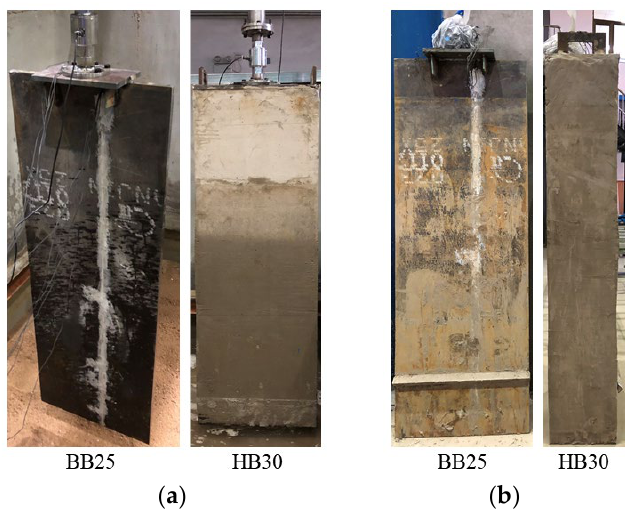
Figure 2. Test models: ( a ) without drag reduction; ( b ) with drag reduction.